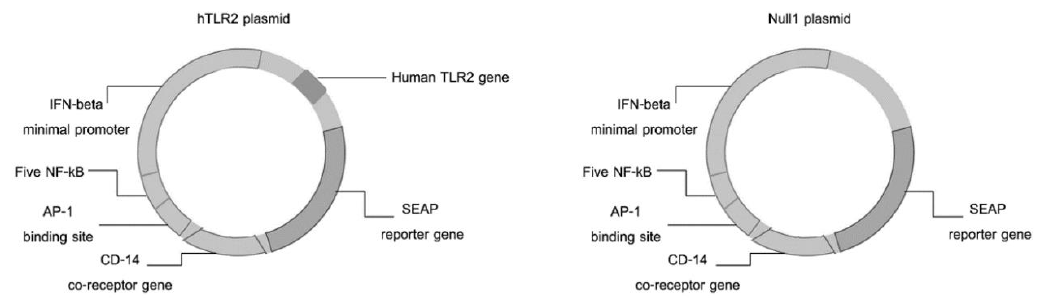
Figure 1. Diagram of the hTLR2 and Null1 plasmids for the cotransfection of the hTLR2 and SEAP reporter genes into HEK293 cells and SEAP without hTLR2 for the Null 1 cell line.